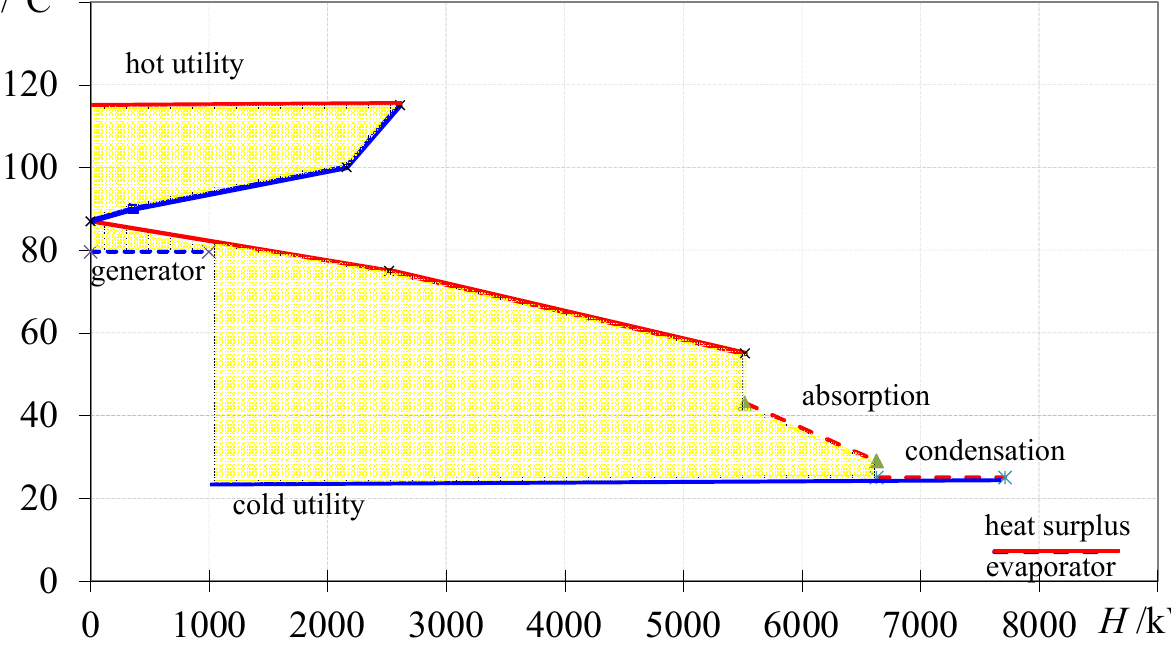
Figure 11. Integration of the AC for the process as case study 1.